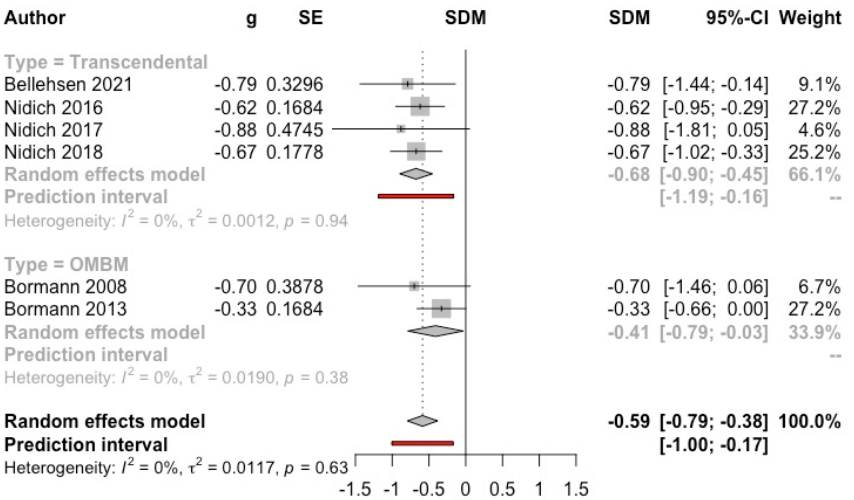
Figure 7. Effect on post-traumatic stress disorder symptoms (meditation vs. control). Predictive intervals are represented in red.